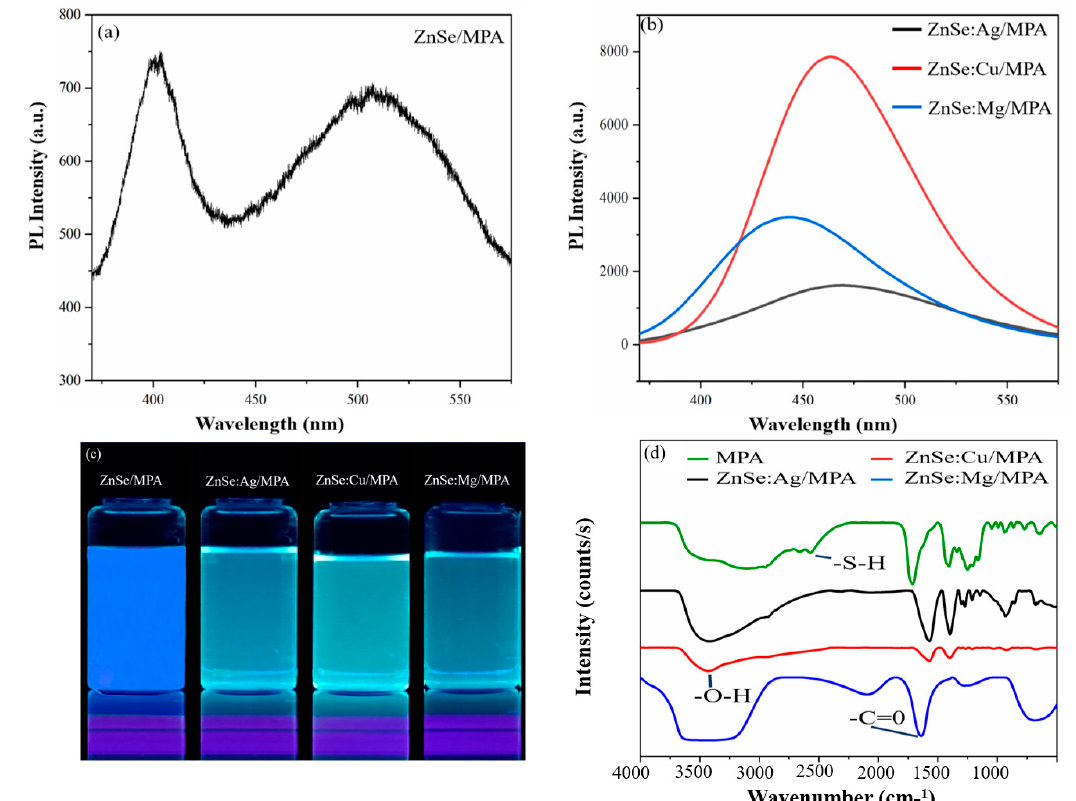
Figure 1. Photoluminescence spectra: ( a ) ZnSe-capped MPA; ( b ) ZnSe:Ag, ZnSe:Cu, and ZnSe:Mg; ( c ) a digital photograph of the UV-irradiated as-prepared solution; ( d ) FT-IR spectra of ZnSe:X (1%) nanoparticles under UV light ( λ exc = 365 nm).